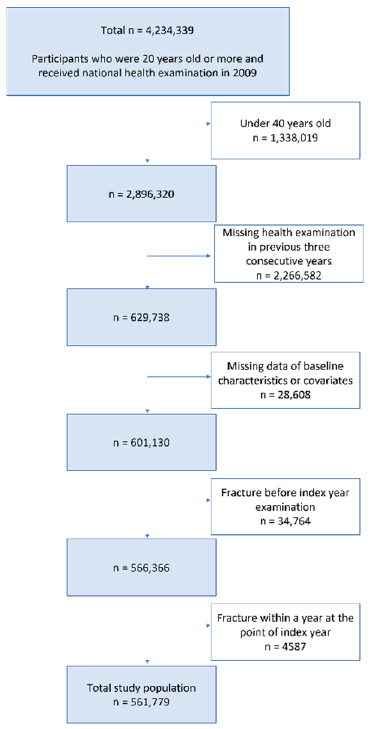
Figure 1. Flowchart of the inclusion and exclusion